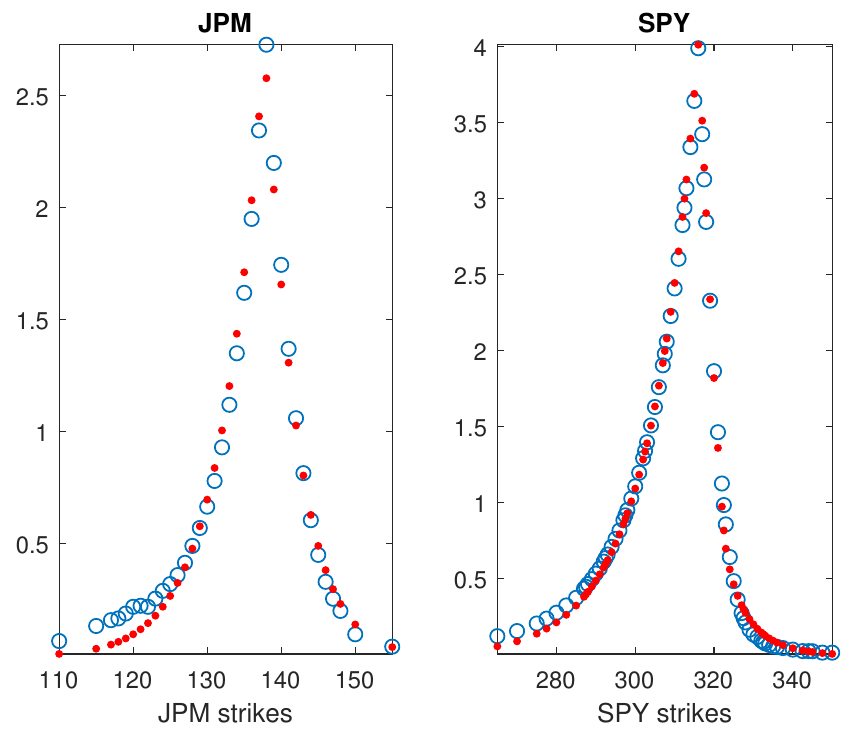
Figure 1. Bilateral Gamma marginals fit to JPM and SPY options for a maturity of 29 days on 12 December 2019. The circles represent marlet prices. Model prices are shown by dots.